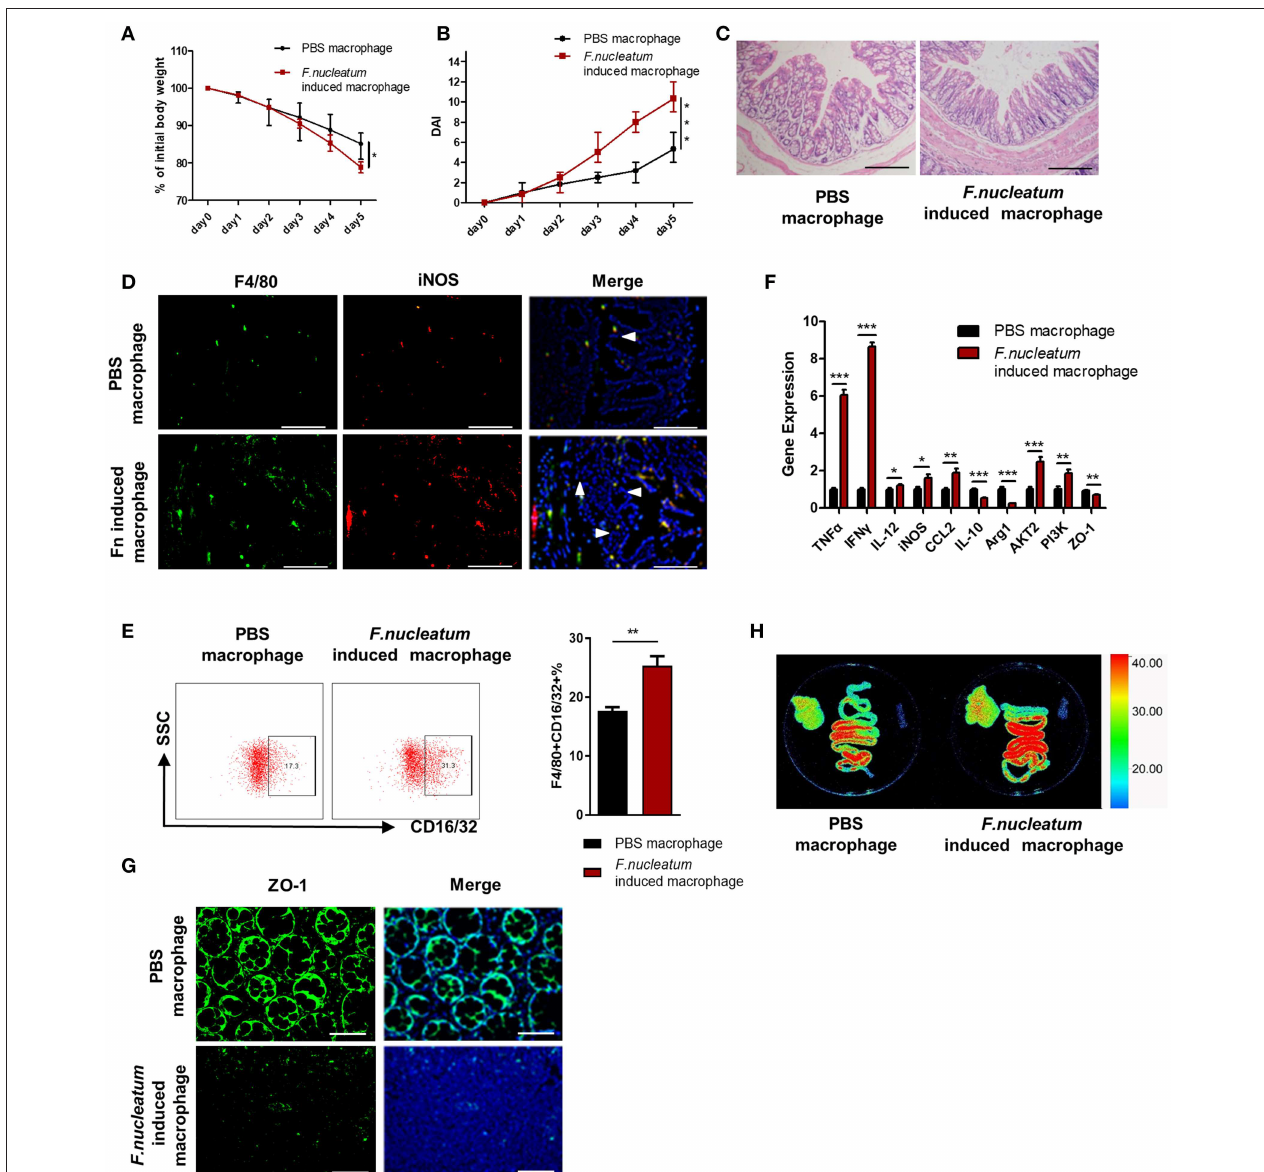
FIGURE 6 | Adoptive transfer of F. nucleatum -induced macrophages aggravates colitis progression. F. nucleatum -treated BMDMs were collected and injected into the abdominal cavity of mice 48h before initiation of DSS. (A) Body weight was measured daily, n = 6 mice per group. (B) DAI scores were recorded daily, n = 6 mice per group. (C) Mucosal tissues collected on day 5 were H&E stained, with representative images shown to assess colitis severity. Representative images are shown. Scale bars, 50 µ m. (D) Mucosal tissues were stained by F4/80 (green) and iNOS (red) in macrophages; DAPI (blue) served as a nuclear stain. Representative images are shown. Scale bars, 50 µ m. (E) F4/80 and CD16/32 staining of LP cells. Ratio of F4/80 and CD16/32 double positive cells were performed. (F) Expression of TNF- α , IFN - γ , IL-12, IL-10, MCP-1, Arg-1, iNOS, and ZO-1 was measured by qRT-PCR in colon tissues. (G) Mucosal tissues were stained with ZO-1 (green); DAPI (blue) served as a nuclear stain. Representative images are shown. Scale bars, 10 µ m. (H) Ex vivo images of the liver, spleen and intestine 12h after ERFP- E. coli gavage. Representative images are shown. Each experiment was performed at least three times. Data are presented as means ± SD. * P < 0.05; ** P < 0.01; *** P < 0.001; Analysis of Variance (ANOVA) and Student’s t -test